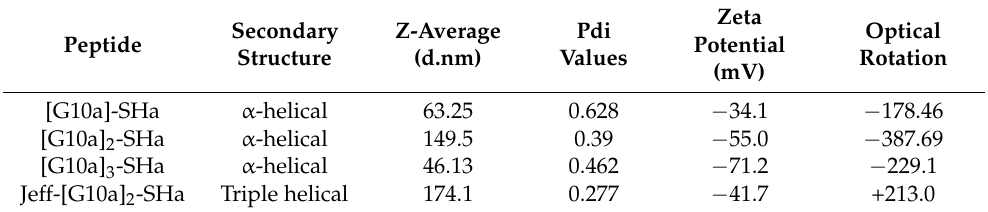
Figure 3. DLS intensity profile: ( A ) average size of [G10a] 2 -SHa using Zetasizer, ( B ) atomic force microscopic image of [G10a] 2 -SHa. Table 3. Key nano-scale parameters of dendrimers of temporin SHa showing zeta size and potential along with polydispersity index values. Moreover, α -D values of dendrimers show their optical